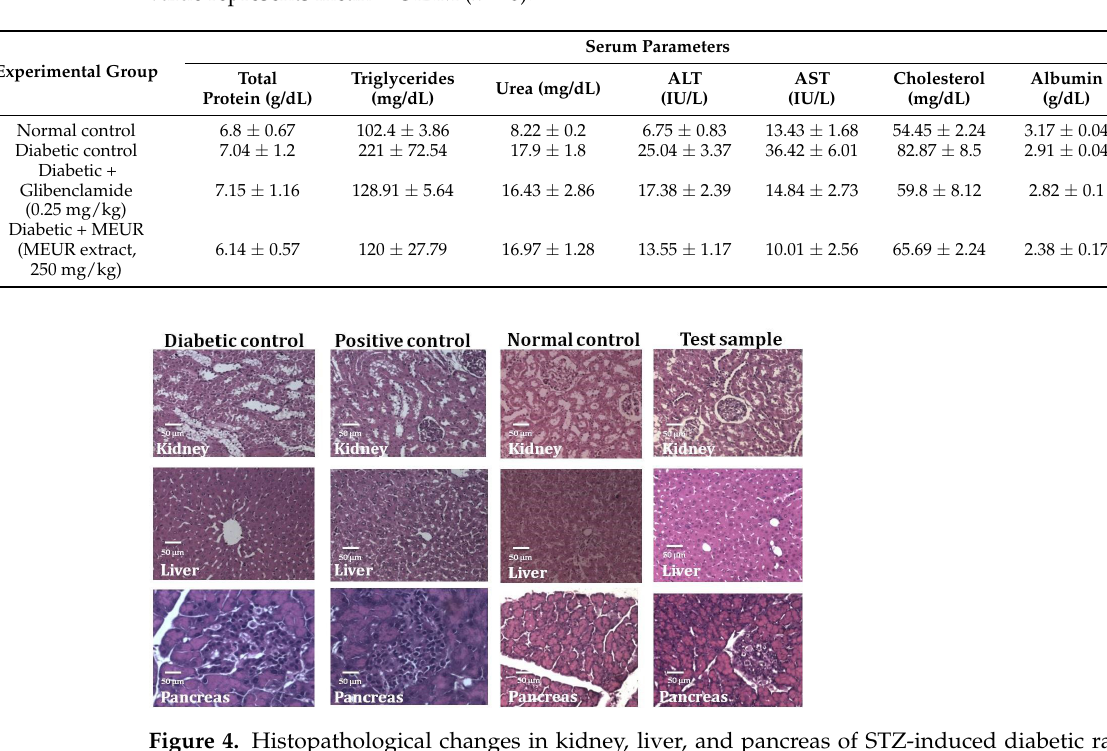
Figure 3. Effect of MEUR on body weight of STZ-induced diabetic rats. Each value is expressed as mean ± S.E.M. ( n = 6). The mean values were analyzed using two-way ANOVA (Tukey’s multiple comparisons test). * p < 0.05 considered as significant. Table 2. Effect of MEUR on levels of various serum parameters of STZ-induced diabetic rats. Each value represents mean ± S.E.M ( n = 6).